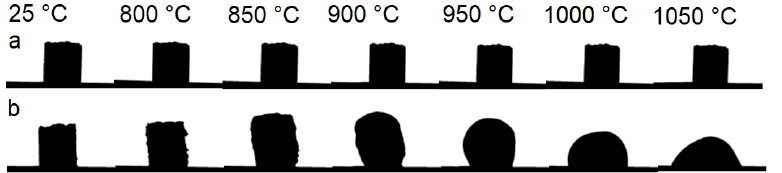
Figure 5. Comparison of sample shape change upon heating. ( a ) raw diatomite, ( b ) diatomite +NaOH.